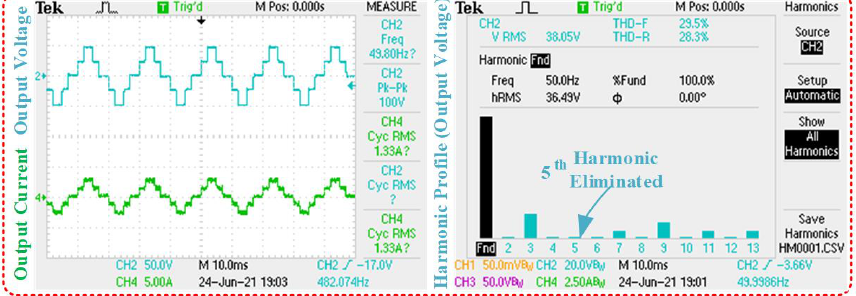
Figure 24. Outputs and harmonic profile of five-levels MLI.